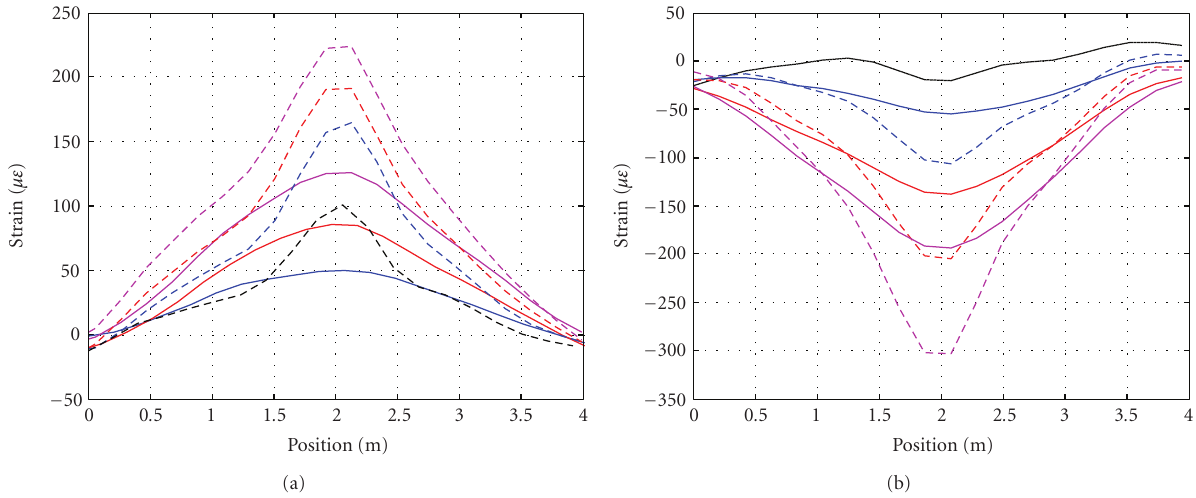
Figure 4: (a) Measured strain distribution along the length of the beam with fiber bonded with epoxy resin (position B); (b) measured strain distribution along the length of the beam with fiber bonded with epoxy resin (position A). Solid line = loading step. Dashed line = unloading step. Blue line = 50 daN. Red line = 100daN. Magenta line = 150daN. Black line = 0 daN.